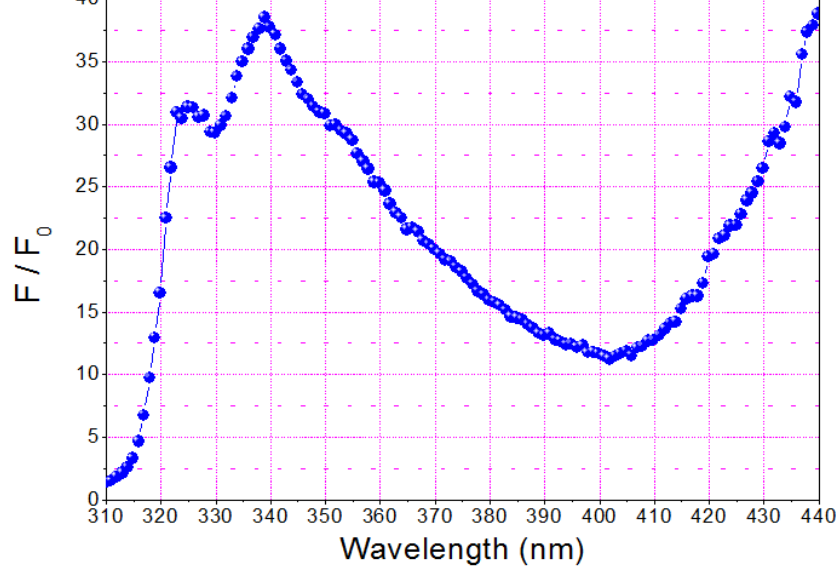
Figure 4. Wavelength emission dependence of metal-enhanced fluorescence; the fluorescence enhancement factor (F/F concentration of silver nanoparticles, as shown in Fig. 3. Despite the large number of probed concentrations, spectra representing six nanoparticles concentrations are presented in Fig. 3 for better visualization. We also found that the increase in the rate of absorbance at the plasmon resonance peak was ~ two times higher than at the Trp absorption peak, as shown in the inset of Fig. 3.